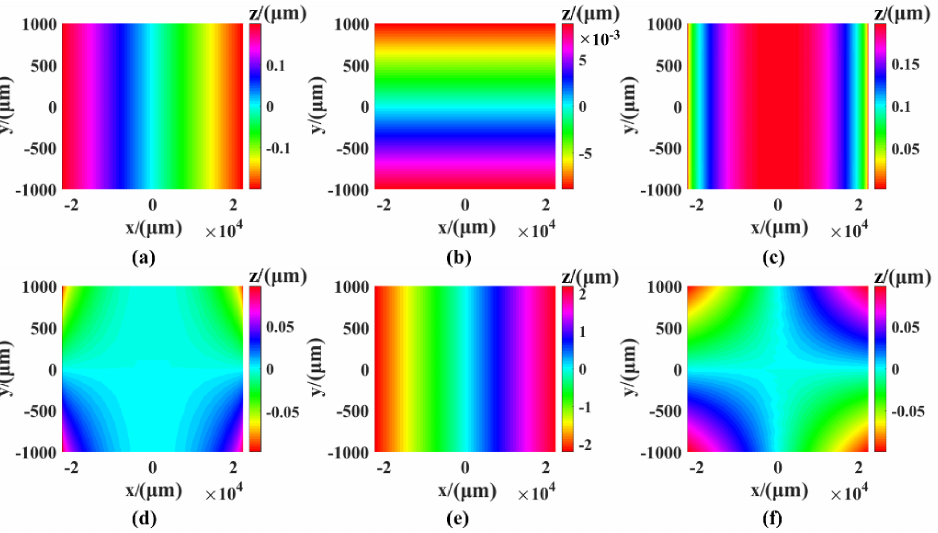
Figure 3. The shape error caused by X-axis movement: ( a ) Positioning error, ( b ) Y-direction straightness error, ( c ) Z-direction straightness error, ( d ) pitch angle error, ( e ) yaw angle error, ( f ) rolling angle